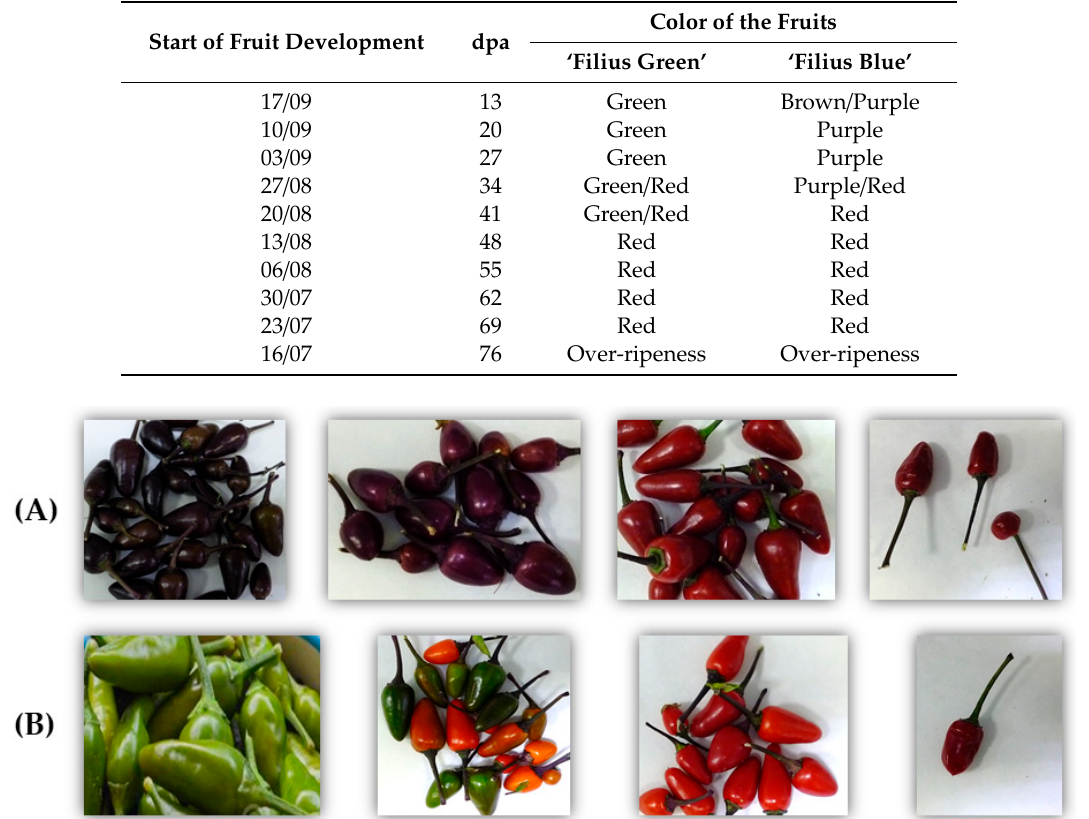
Table 1. Color of ‘Filius’ pepper fruits at the different stages of their development (dpa: days post-anthesis).